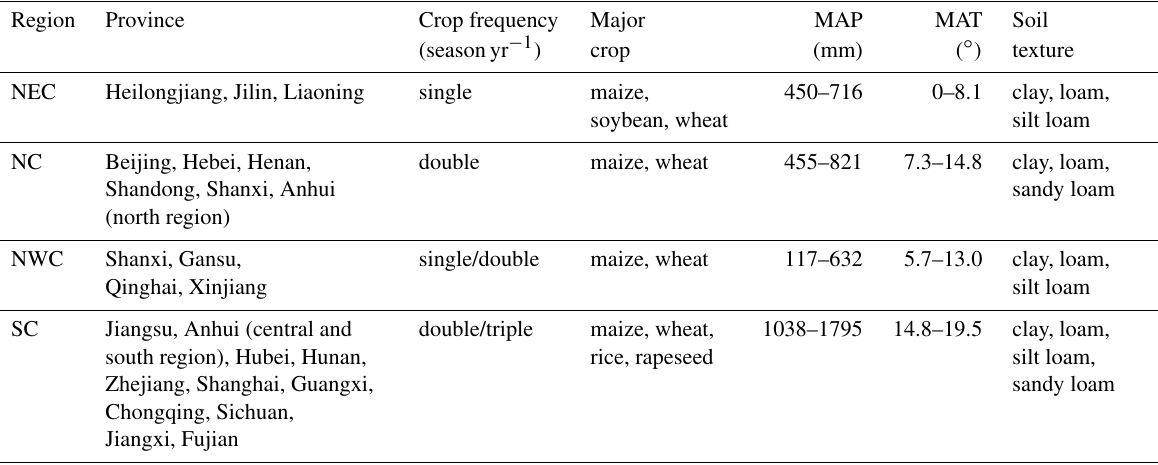
Table 2. Basic information on agricultural regions in the current analysis.